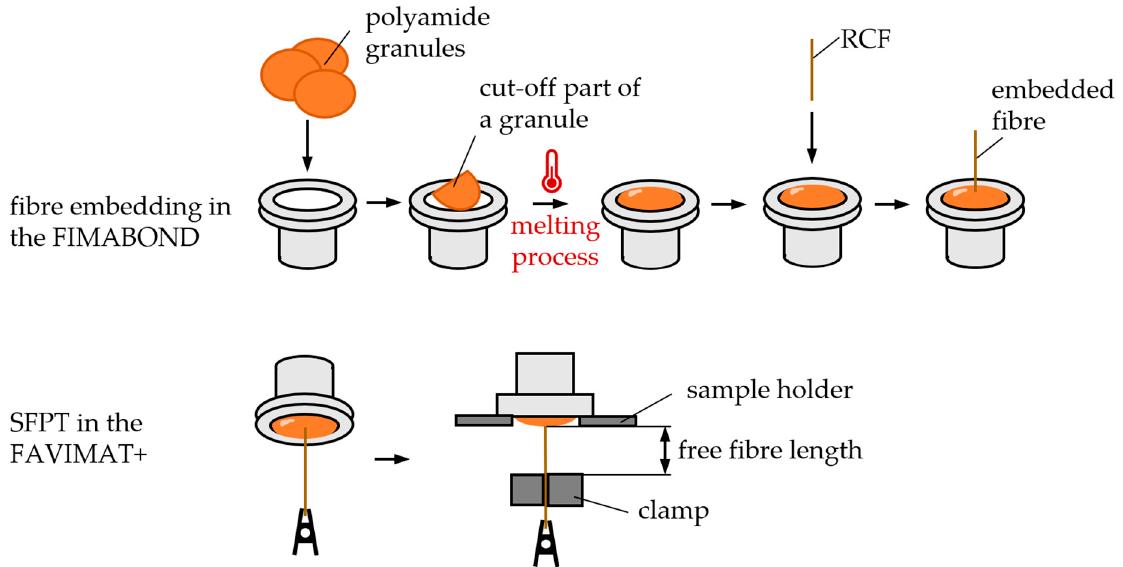
Figure 2. Illustration of the embedding process and pull-out testing.